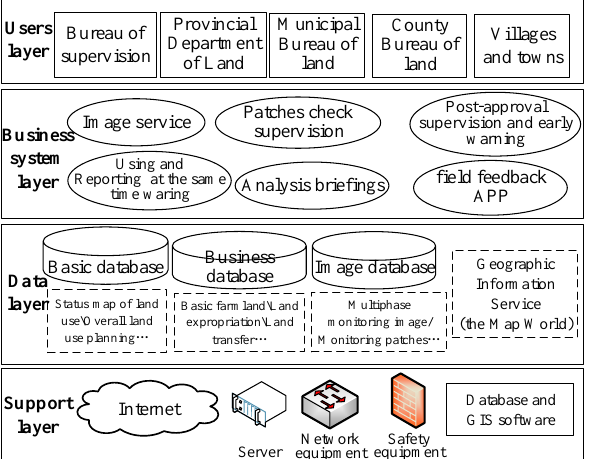
Figure 3. The overall architecture of